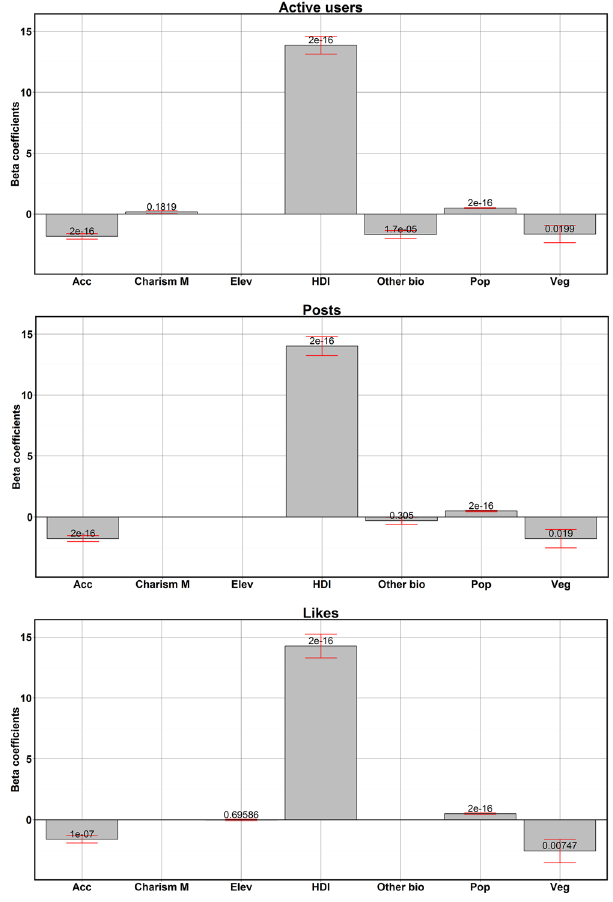
Figure 2. Beta coefficients of best predictors, averaged among the 6 top models of each response variable explaining use of social media in protected areas. The red bars show the confidence interval for each coefficient. The number over each bar are p-values and refer to the statistical significance. Figure S2 in Appendix S1 shows the values corresponding to this